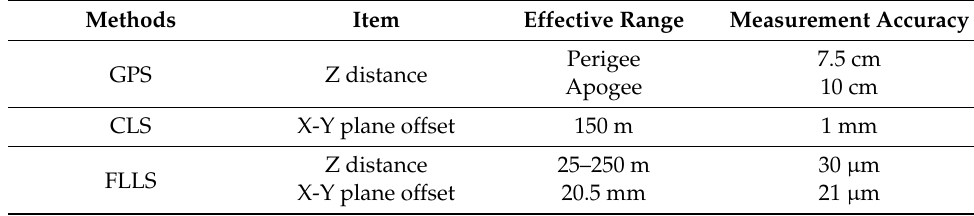
Table 4. Proba-3 measuring system performance